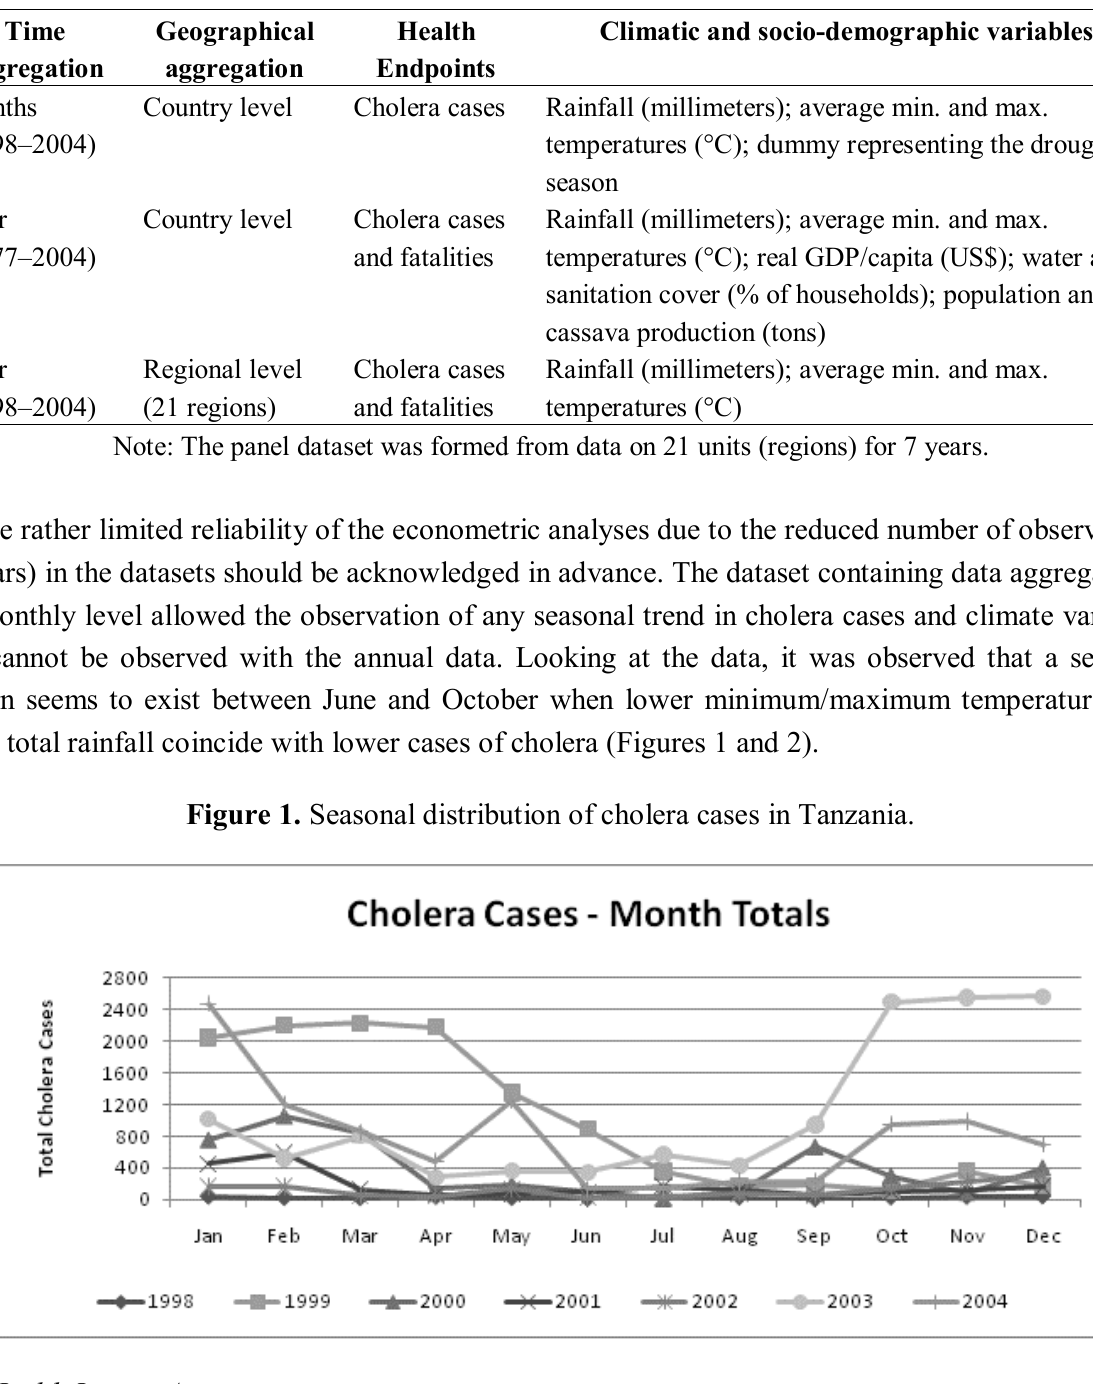
Table 1 . Overview of datasets.